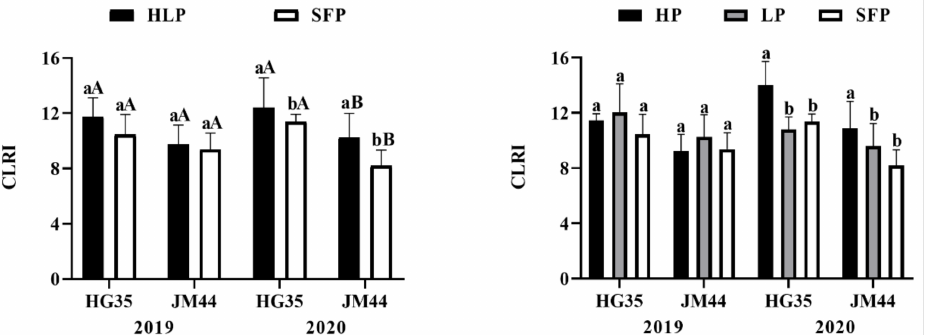
Figure 3. Effects of sowing modes on culm lodging resistance index (CLRI). HG35: Hengguan 35; JM44: Jimai 44. HLP: high-low-plot sowing mode; SFP: small-flat-plot sowing mode. The same lowercase letters indicate that the difference between sowing modes was not significant. The same uppercase letters mean the difference between cultivars was not